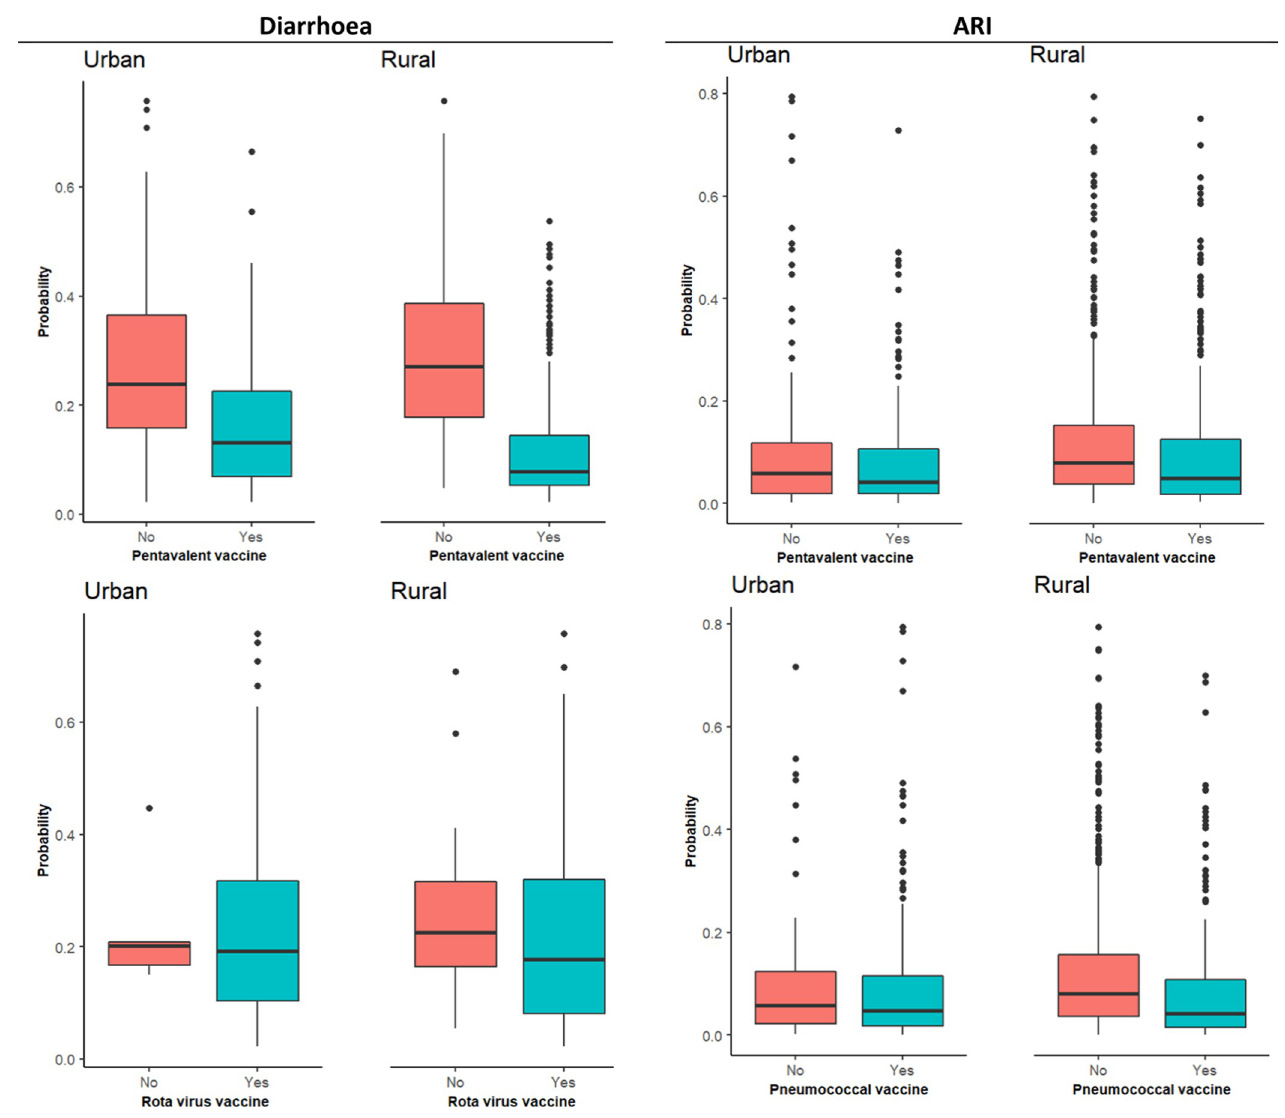
Fig 7. Association of vaccination with child